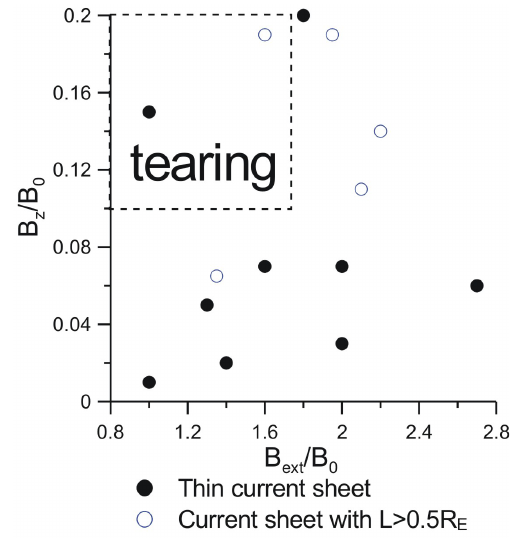
Fig. 11. Parametric map of the model instability region and experi- mental points from 2001 and